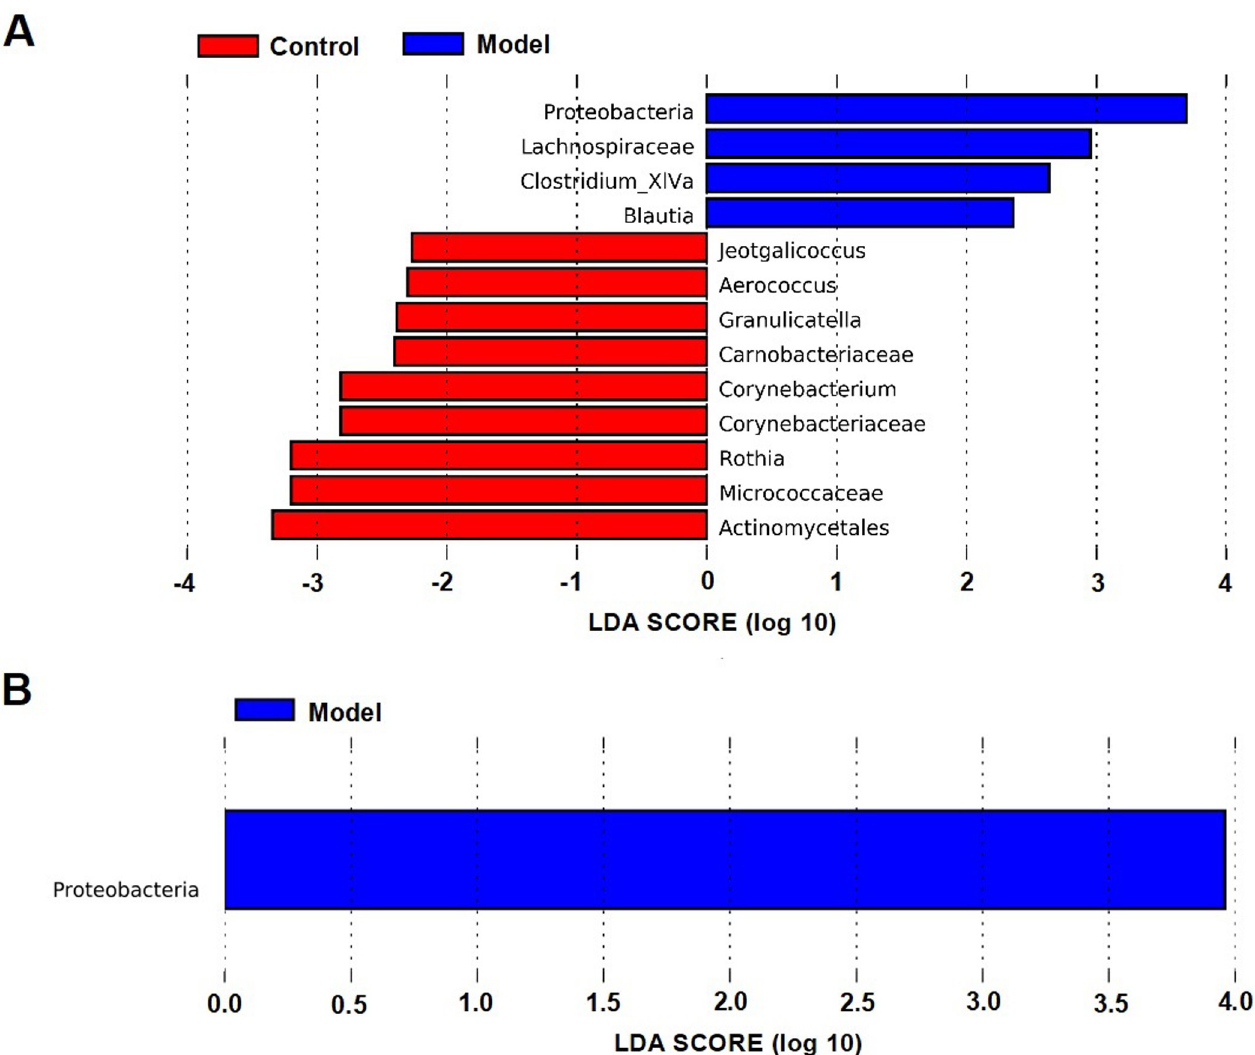
Fig 4. The significantly enriched bacterial taxa in different groups as determined by LEfSe analysis. (A) Pairwise taxonomic LEfSe analysis of the control and the model groups. (B) Pairwise taxonomic LEfSe analysis of the model and the treatment groups. (LDA score > 2.0, P < 0.05).